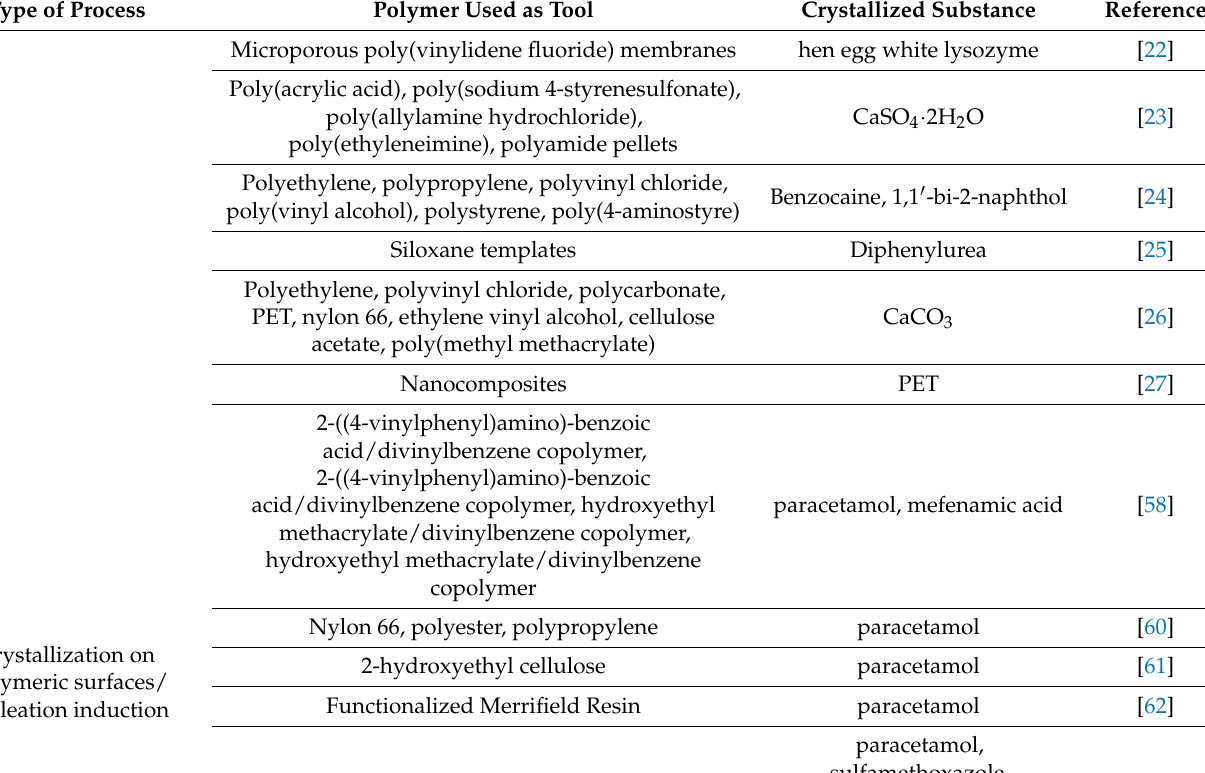
Table 2. Crystallization on polymeric surfaces/nucleation induction: Polymers and crystallized substances. Type of